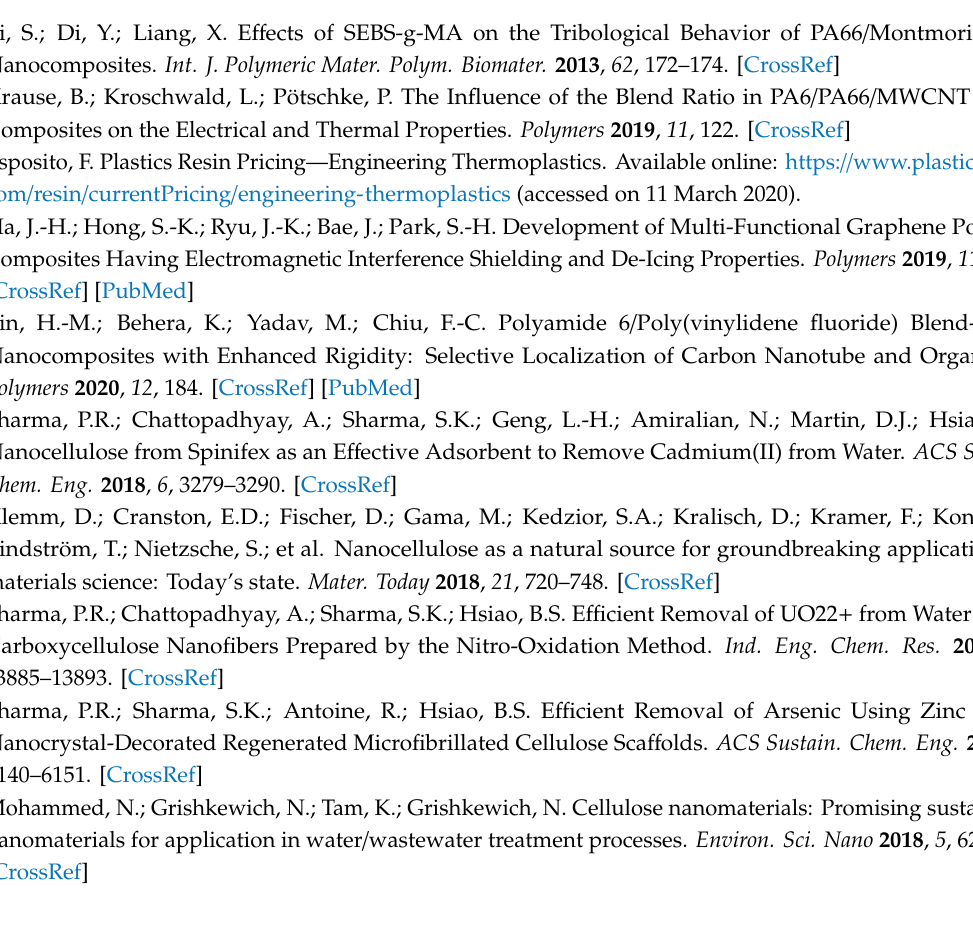
Figure S1: Digital photo of the prepared biocomposite samples (a) Neat PA66, (b) 20 wt% BioC500 reinforced PA66 and (c) 20 wt% BioC900 reinforced PA66. Table S1: Mechanical Properties of PA66 / BioC composites at 20 wt%. Video S1: